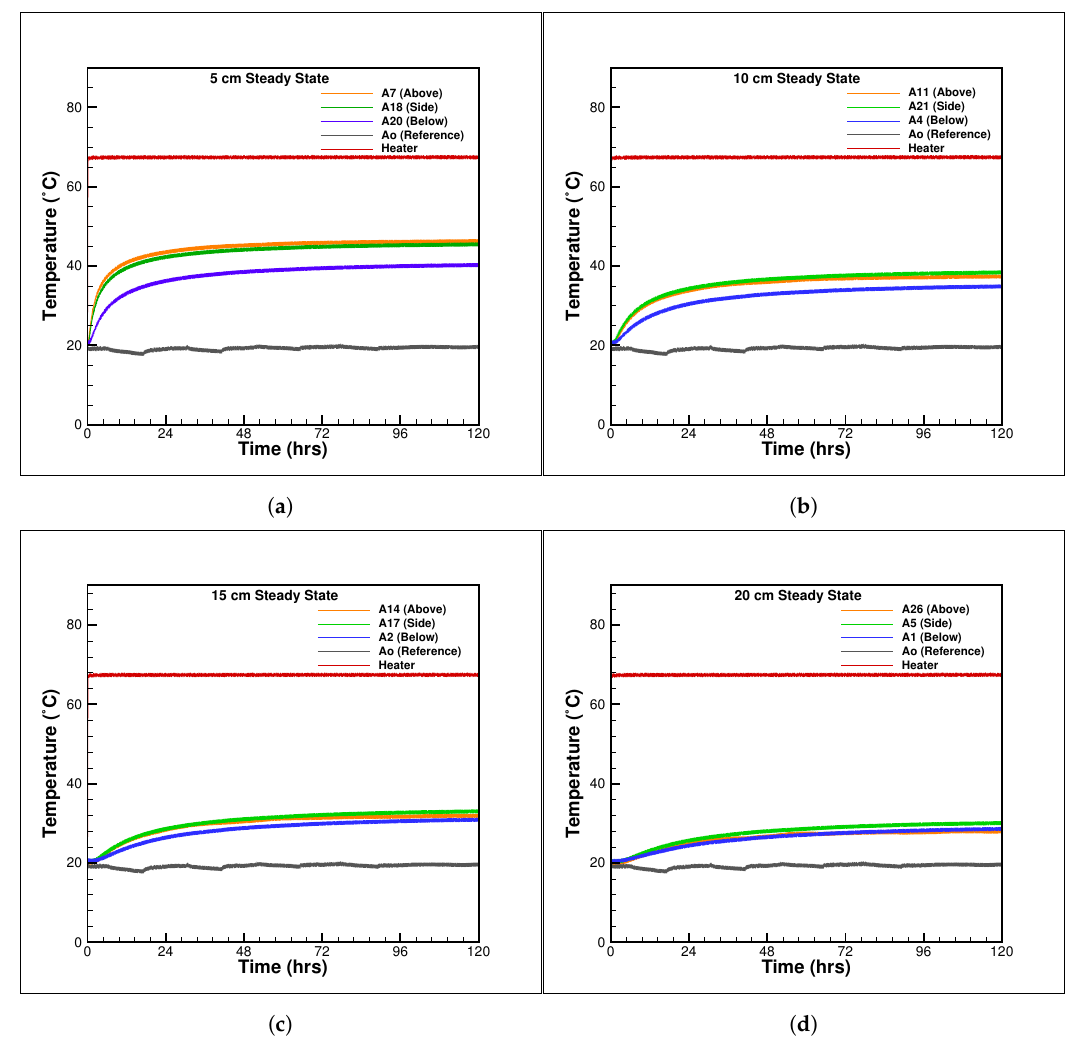
Figure 6. Temperature plot with 5 days constant temperature heating of 70 °C of thermocouples at ( a ) 5 cm; ( b ) 10 cm; ( c ) 15 cm; ( d ) 20 cm from the heater